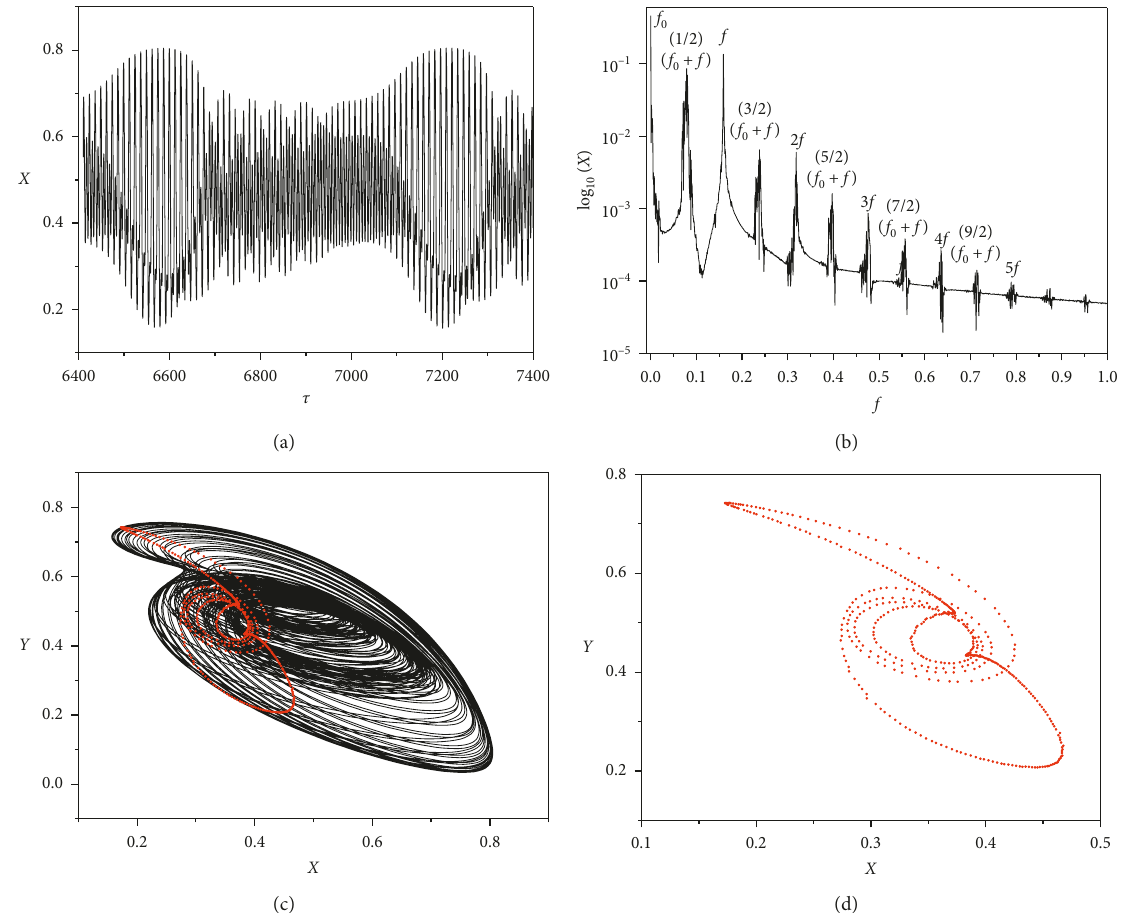
Figure 8: (a) Displacement. (b) Frequency response. (c) Rotor orbit. (d) Poincar´e map where